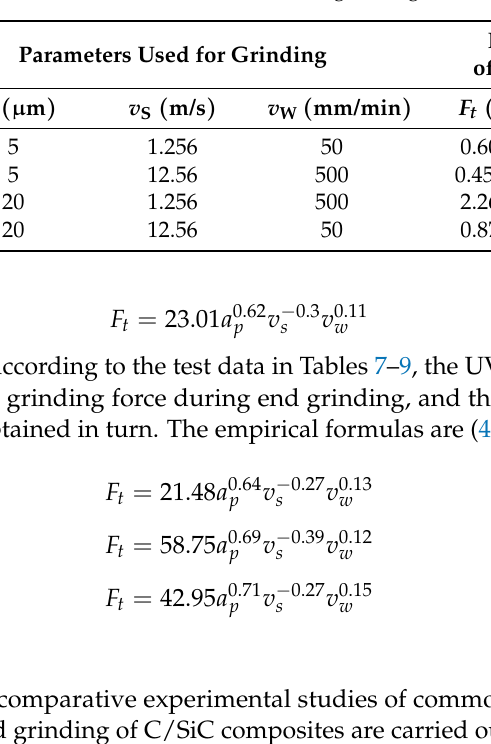
Table 9. Grinding force test data of end-ultrasonic-assisted